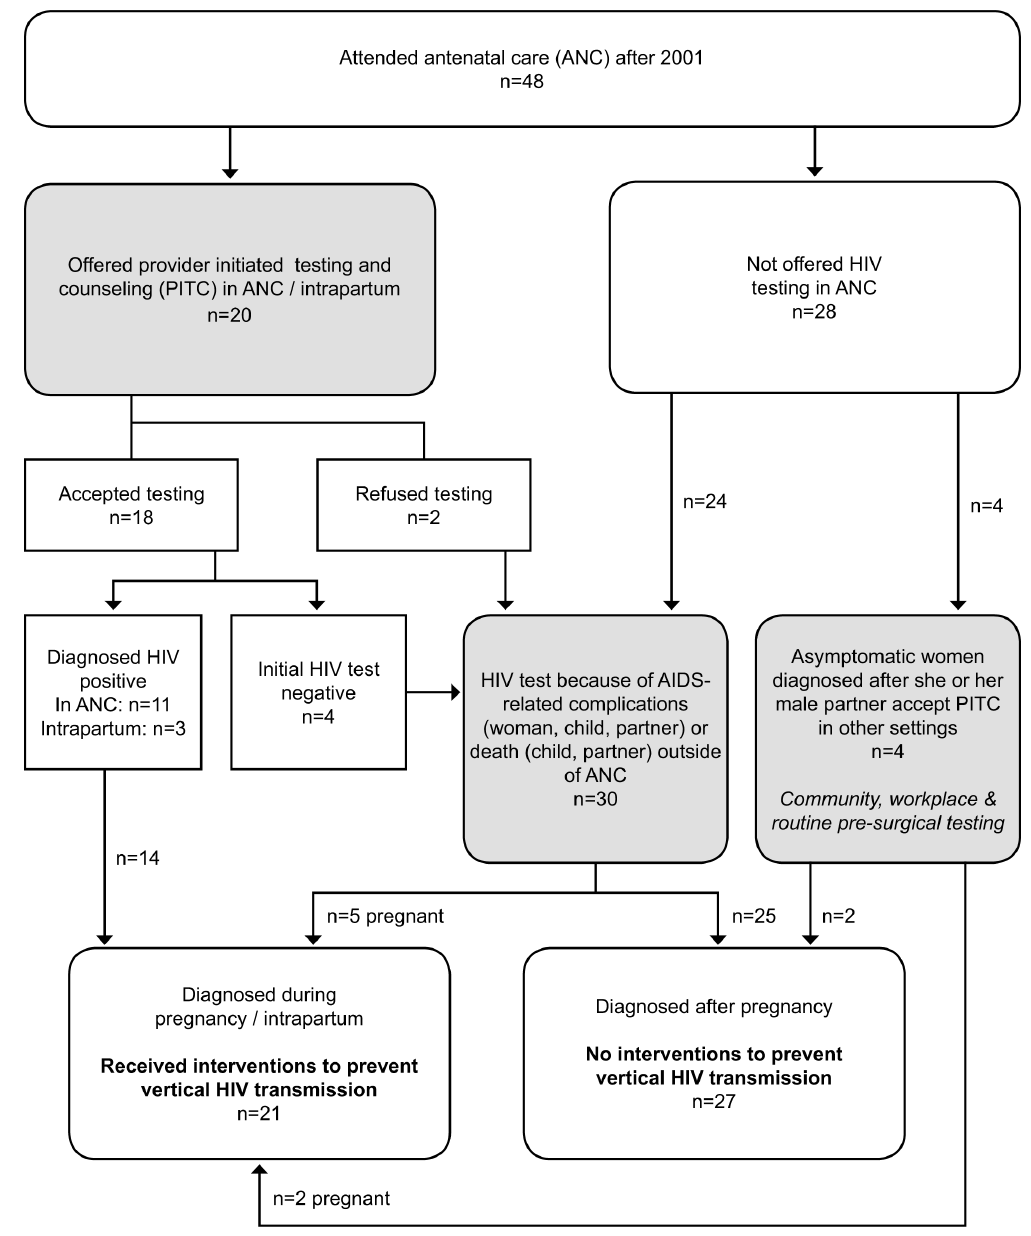
Figure 1. Routes to HIV diagnosis for Mexican women who attended antenatal care (ANC) after 2001.